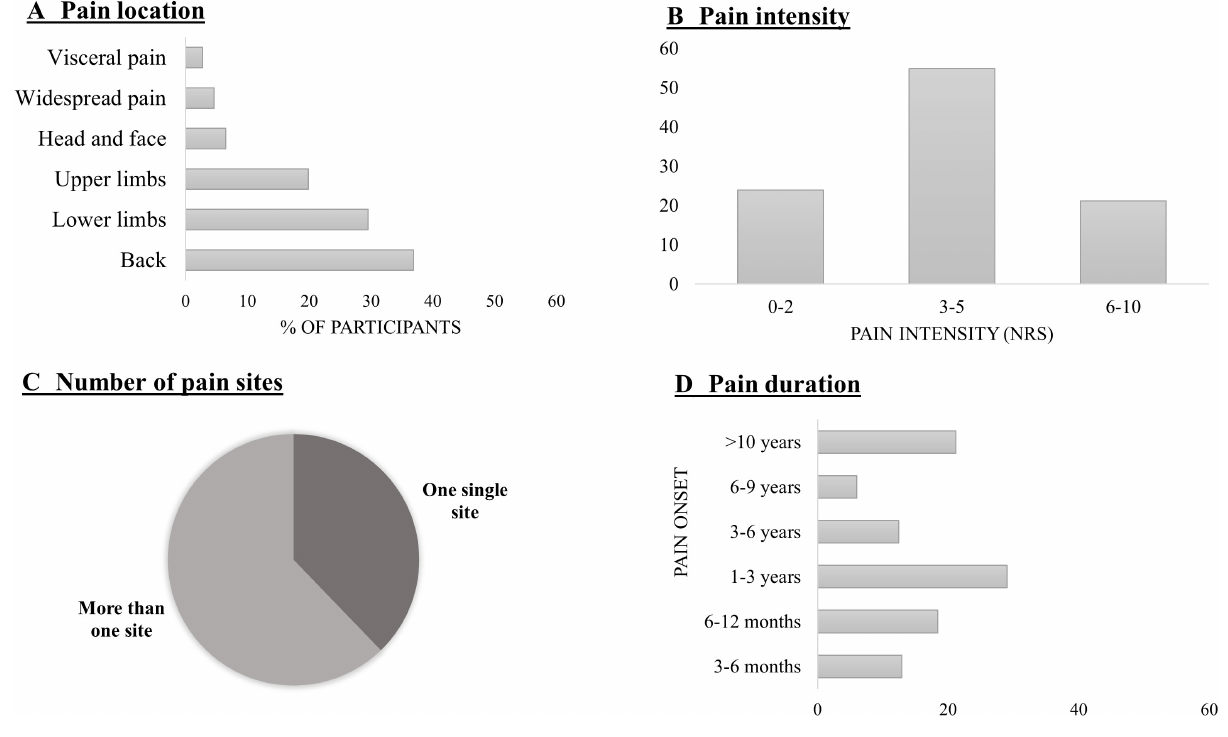
FIGURE 3 | (A) Number of participants (in %) in each pain location; (B) Percentage of participants according to their last week pain intensity perception in an NRS (Numerical Rating Scale). Ratings have been classified into three main groups: from 0 to 2; 3–5; 6–10; (C) Population (in %) with one pain site (or one kind of pain) and more than one site; (D) Participants’ pain onset, classified in 3–6 months; 6–12 months; 1–3 years; 3–6 years; 6–9 years, and more than 10 years.